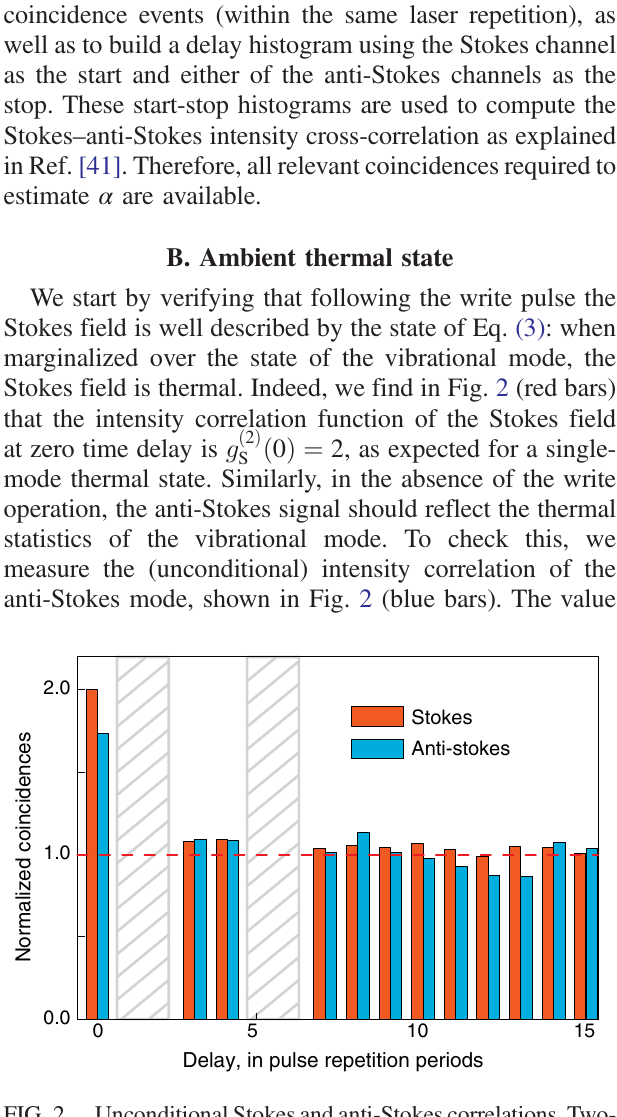
FIG. 2. Unconditional Stokes and anti-Stokes correlations. Two- photon coincidence histograms of the Stokes field ˆ a (write pulse S energy 60 pJ, acquisition time 10 min) and anti-Stokes field ˆ a AS (read pulse energy 372 pJ, acquisition time 60 min). For the anti- Stokes field the coincidences are recorded between the detectors ˆ ˆ d 1 and d 2 as in Fig. 1(b), while the write pulse is measuring blocked. For the measurement of the Stokes field, a beam splitter is added in the path of mode ˆ a . The start-stop delay (horizontal axis) S is scaled in multiples of the repetition period ≈ 12 . 5 ns. After normalizing by the average number of accidental coincidences (the peaks at nonzero start-stop), the value at zero time delay represents the intensity correlation of the Stokes and anti-Stokes fields; ð 2 Þ ð 0 Þ ¼ 2 . 0 (cid:3) 0 . 1 and g ð 2 Þ ð 0 Þ ¼ 1 . 73 (cid:3) 0 . 11 . The namely, g S AS hatched regions in gray, omitted in the analysis, are affected by spurious coincidences due to cross talk between the two detectors, which arise when hot-carrier-induced light emission from one detector [47] is received by the other